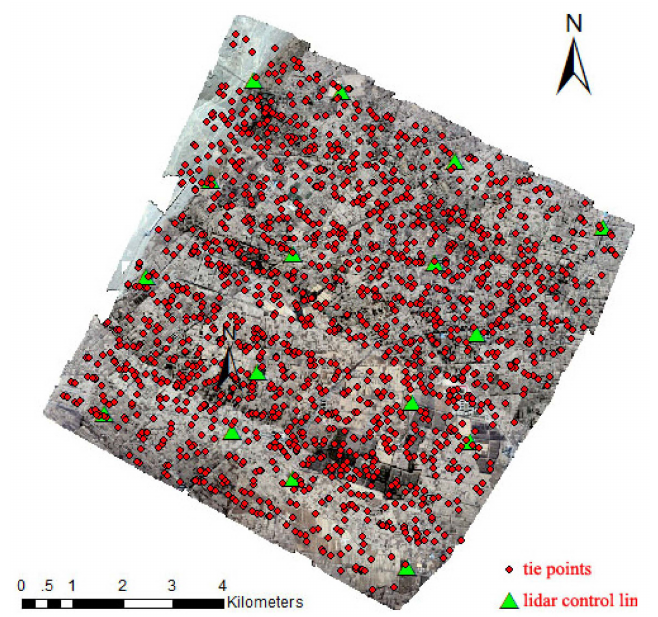
Figure 6. Distribution of the 16 linear control features and tie points.